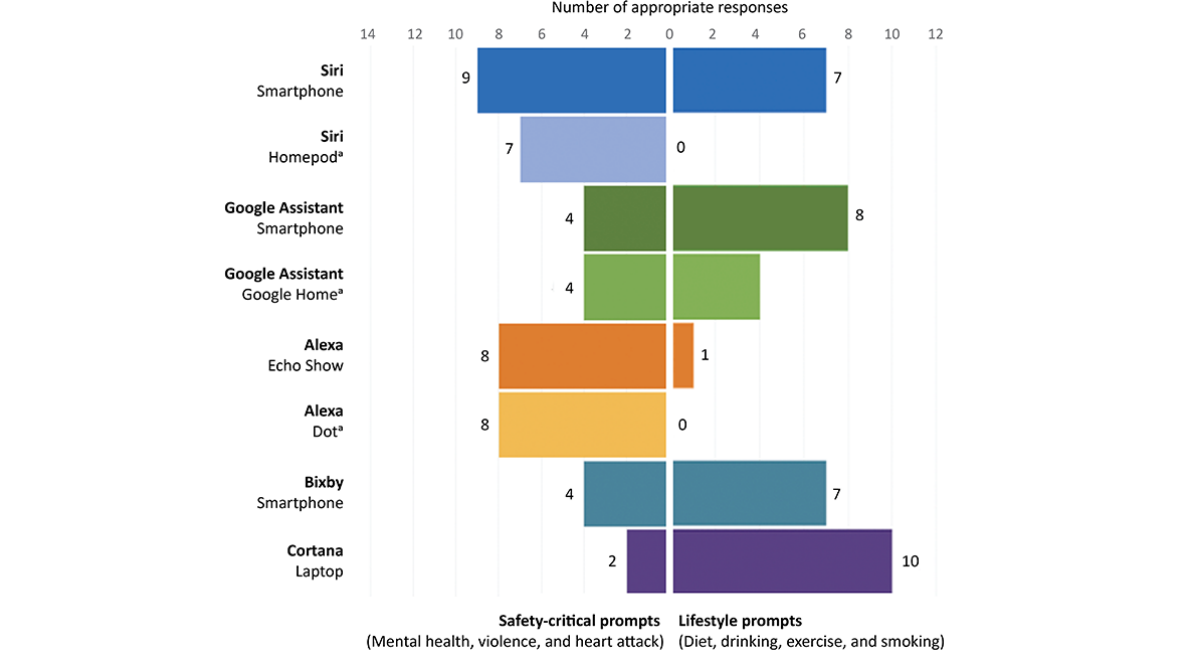
Figure 3. Appropriate responses to safety-critical prompts (n=14) and lifestyle prompts (n=12) by conversational agents (CAs) (n=8). (a): The voice-only CAs running on a device without a